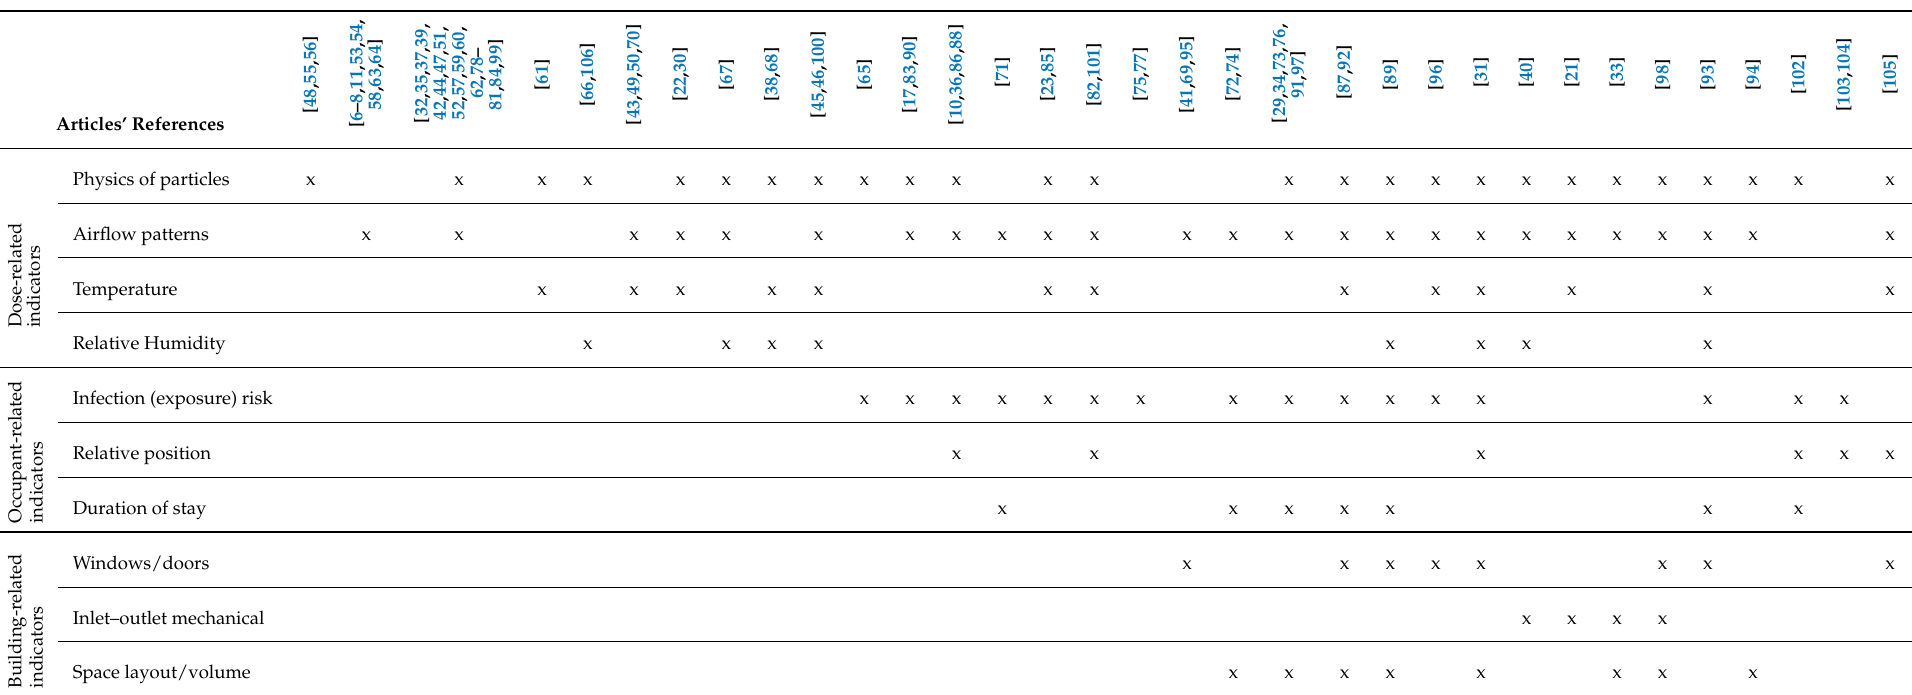
Table 5. Studies grouped according to the three main categories of indicators: dose-, occupant-, and building-related